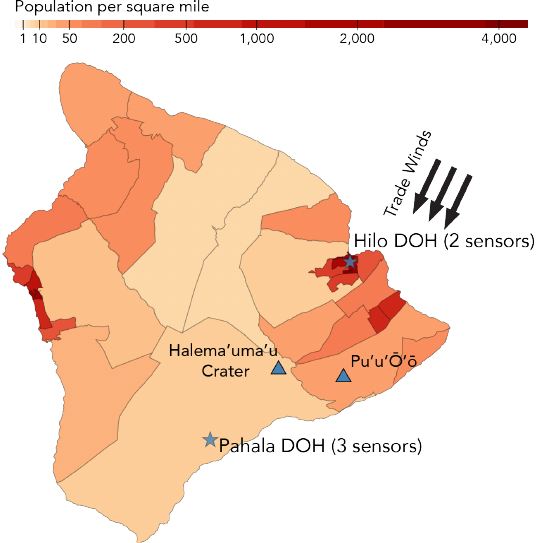
Figure 1. Map of the island of Hawai‘i (colored by population den- sity), showing the primary measurement locations (Pahala, Hilo) and two primary sources of SO 2 (Halema‘uma‘u, Pu‘u ‘ ¯O’¯o). Northeasterly trade winds dominate the local meteorology, send- ing the volcanic smog (“vog”) plume towards Pahala (population ∼ 1300). During winter months, “Kona winds” can push the plume towards Hilo (population ∼ 43300), northeast of the vents.